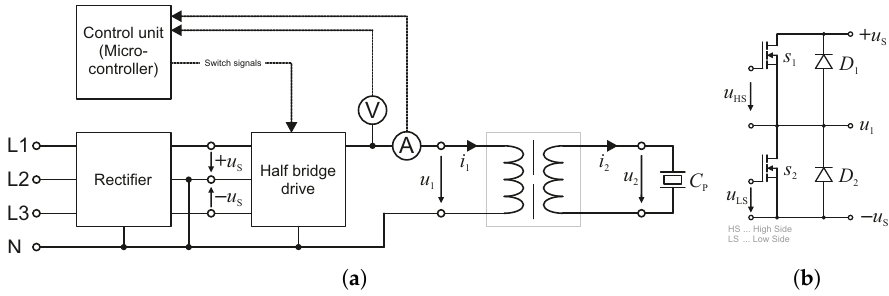
Figure 4. Schematic of electronic circuit. ( a ) basic structure of the electronic circuit; ( b ) simplifeid schematic of the half bridge